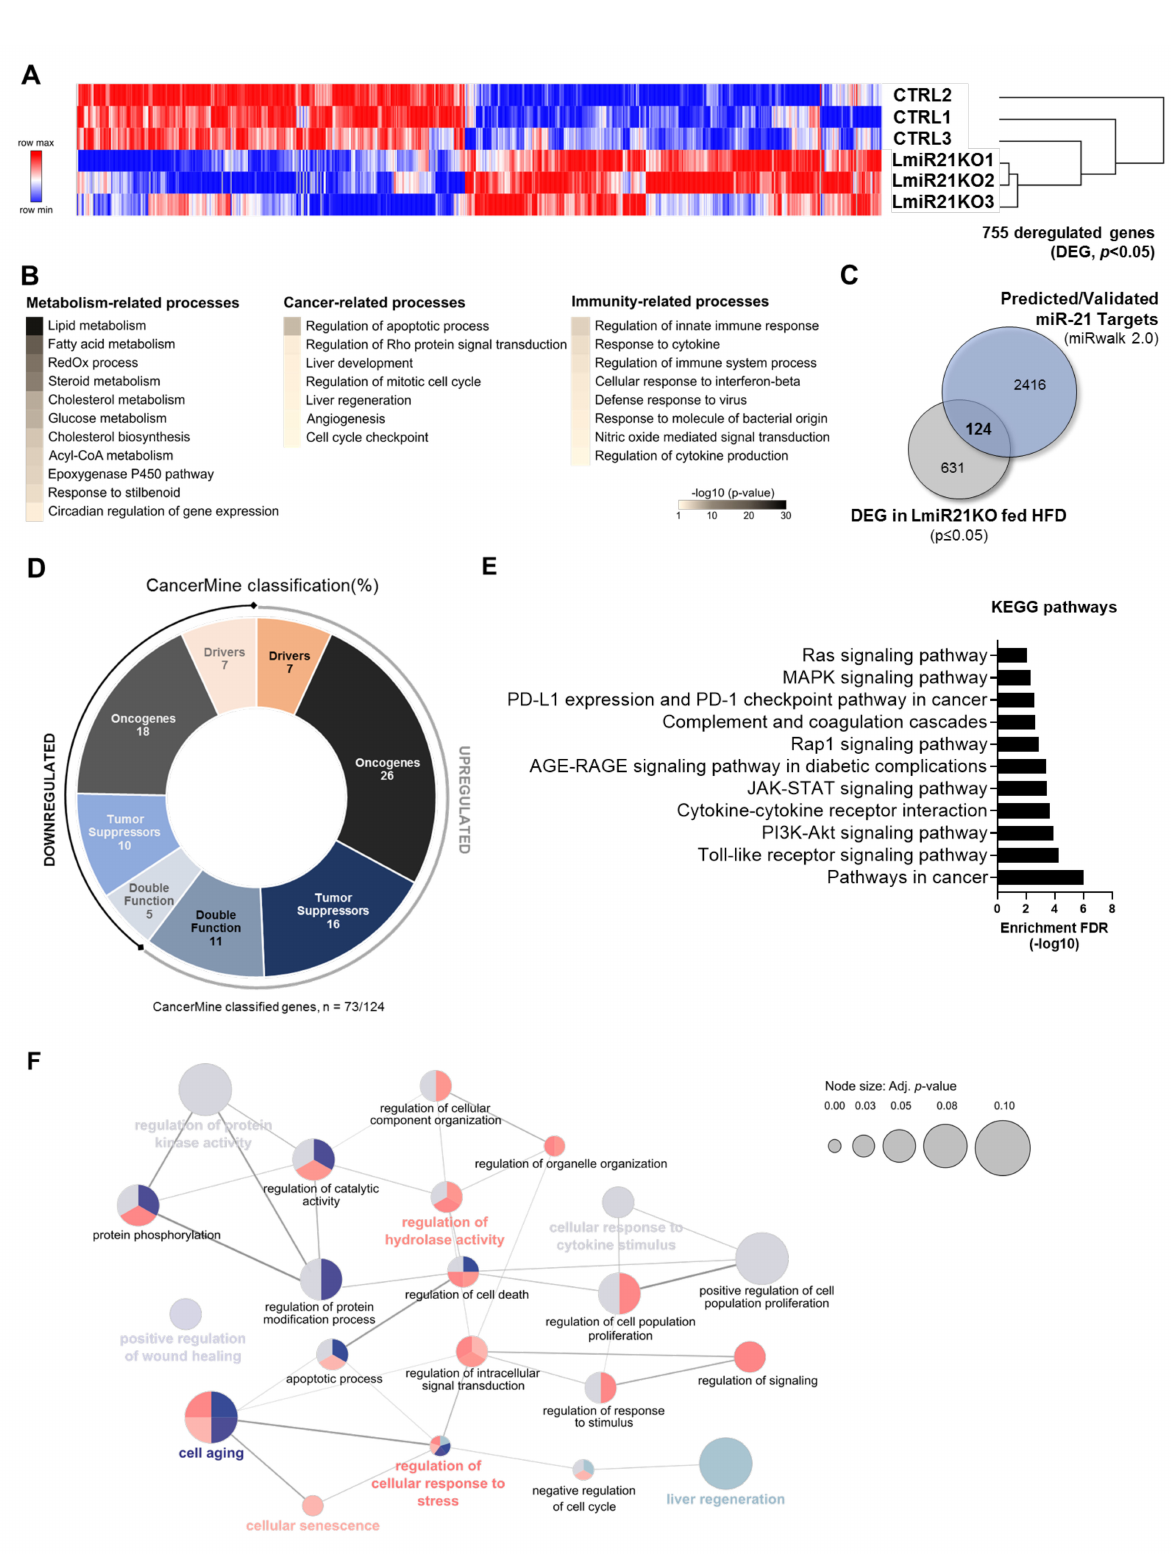
Figure 1. Transcriptomic profile of cancer-related factors altered in hepatic tissues from LmiR-21KO livers. ( A ) Heatmap representation of differentially expressed genes (DEG, p -value < 0.05, |log10FC| > 0.5) identified through RNAseq analysis of explanted liver tissues from control (CTRL) and hepatocyte-specific miR-21 knockout mice fed obesogenic diet (LmiR21KO, HFD 60% of fat, high-fat diet) for 3 weeks ( n = 3 per group, upregulated and downregulated